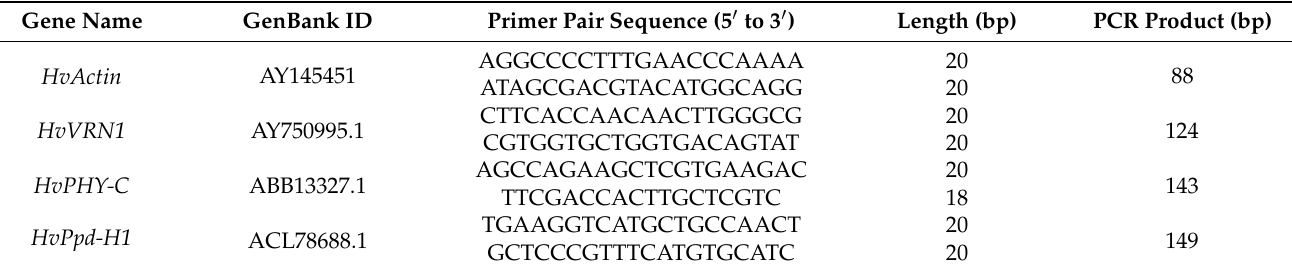
Table 1. List of primer sequences used in this study.